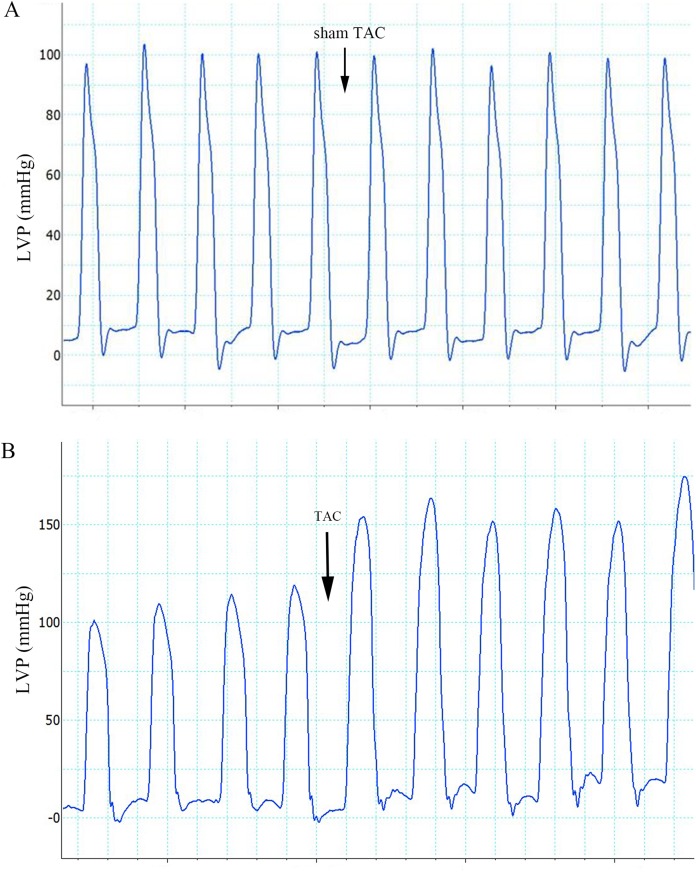
Effects of sham TAC surgery and TAC surgery on LVPs.(A) LVP in rats of group 1 after sham TAC surgery did not show obvious changes. The onset of sham TAC surgery is noted by the arrow. (B) Elevated LVP in response to LV afterload increases (induced by TAC surgery) in rats of group 2. The onset of TAC surgery is noted by an arrow. LVP, left ventricular pressure; TAC, transverse aortic constriction.